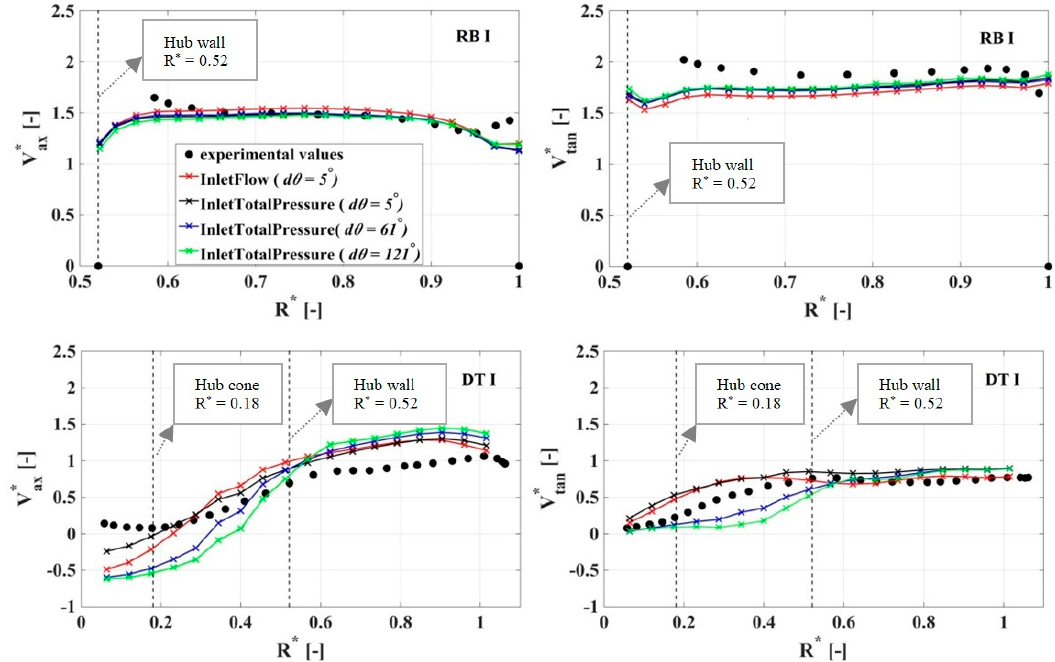
Figure 7. Experimental and simulated axial ( V ax * ) and tangential ( V tan * ) velocity at PL, in the runner blade channel (Section RB I) and below the runner hub (Section DT I). The dotted vertical lines represent the hub wall and cone.